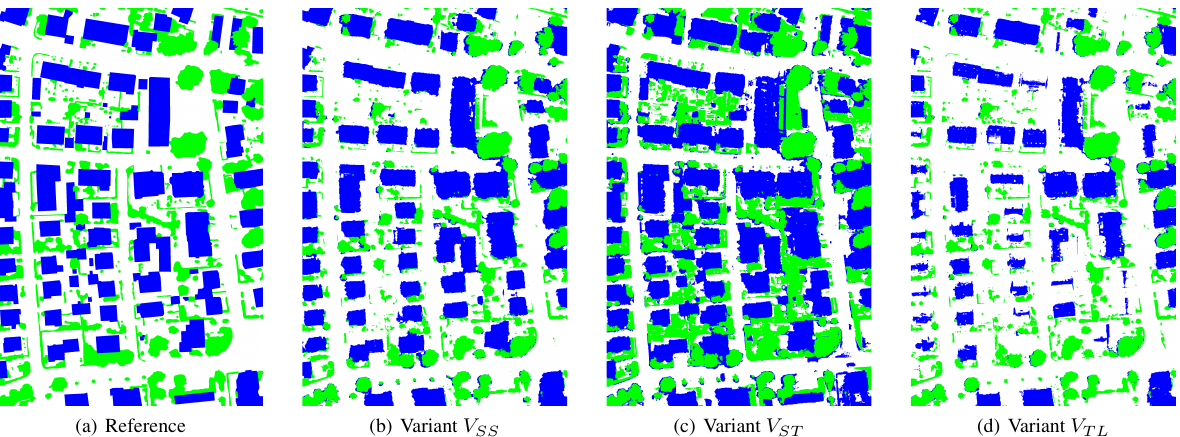
Figure 3: Reference data and results of classification of the test area for the three classification variants explained in the main text. Colours: impervious surfaces (white), building (blue) and tree